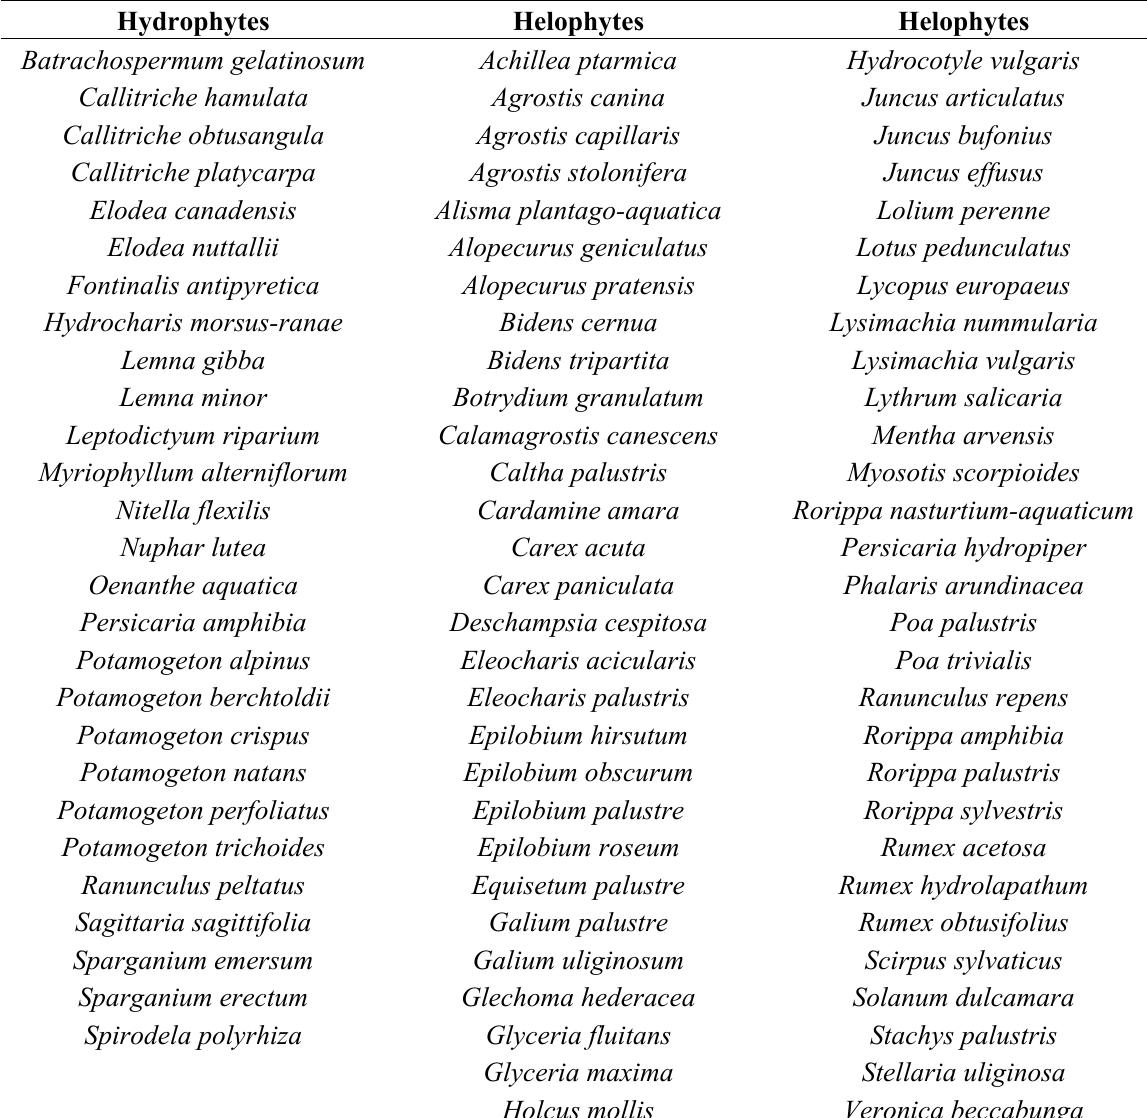
Table A1. List of hydrophyte and helophyte species from the rivers Lethe and Delme (Germany). The nomenclature of the vascular plants follows Stace (1997) New Flora of the British Isles 2nd Ed. Cambridge University Press